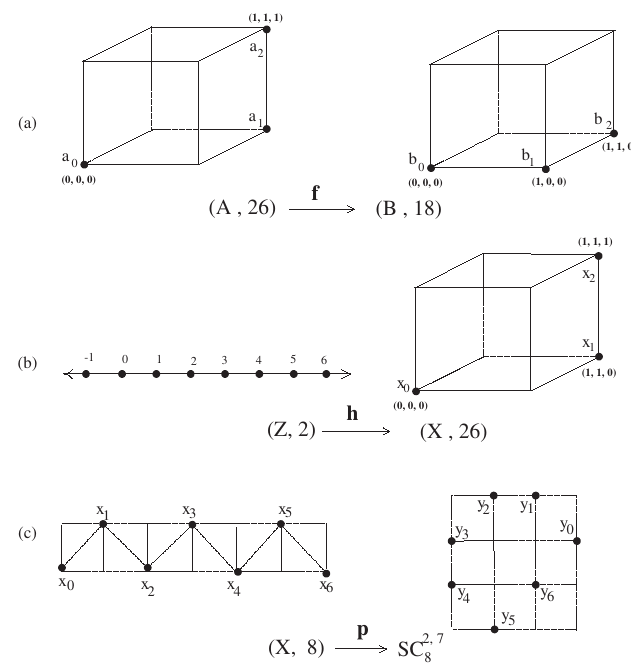
Figure 4. ( a ) Configuration of a ( 26,18 ) -continuous surjection f which is a local ( 26,18 ) -isomorphism ( 2,26 ) -isomorphism stated in Example 3(2). ( c ) Configuration of an ( 8,26 ) -surjection p : ( X ,8 ) → SC 2,7 : = ( y i ) i ∈ [ 0,6 ] which is not a local ( 8,26 ) -isomorphism referred to in Example 3(3), where X 8 Z consists of six